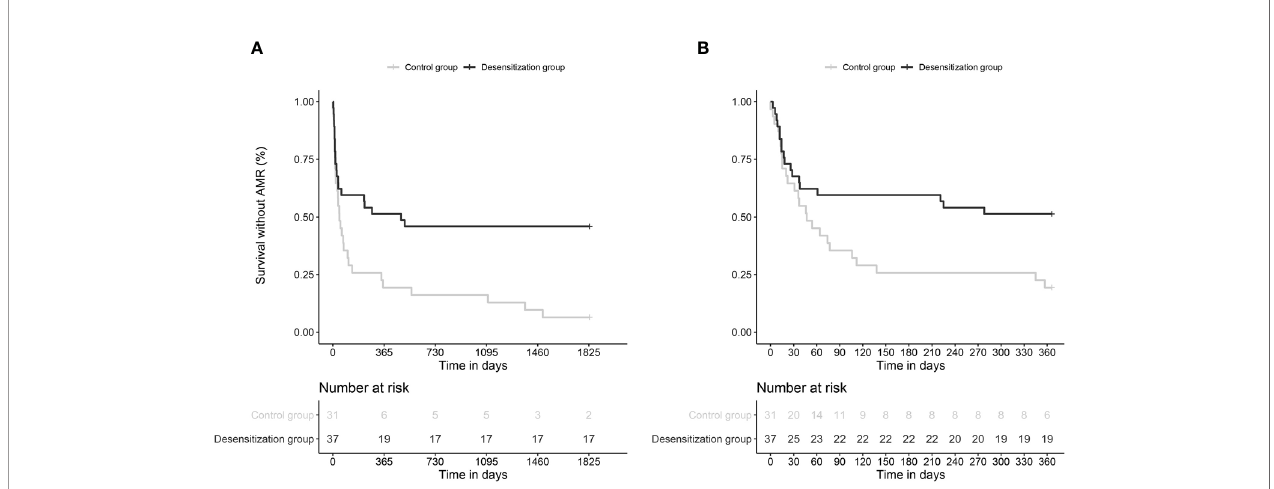
FIGURE 2 | Survival curves comparing the incidence of the main composite endpoint (death and AMR) in desensitized patients and historic control patients, with a 5-year follow-up (A) and 1-year follow-up (B) . (A) . Multivariable Cox survival analyses (with cumulative DSA, age, desensitization intervention, and sex) con fi rmed desensitization was independently associated with fewer events with an adjusted (adj.) HR = 0.44 (0.25-0.79), p = 0.006; the other independent variable being cumulative DSA [per 1000 MFI-increase, adj. HR = 1.031 (1.005-1.057), p = 0.018]. (B) . Multivariable Cox survival analyses (with cumulative DSA, desensitization intervention) yielded a signi fi cant association between desensitization and the primary outcome with 1-year follow-up, adj.HR = 0.49 (0.27-0.91), p = 0.023) and cumulative DSA also independently associated with the primary outcome [per 1000-MFI increase, adj.HR=1.028 (1.002-1.053), p =